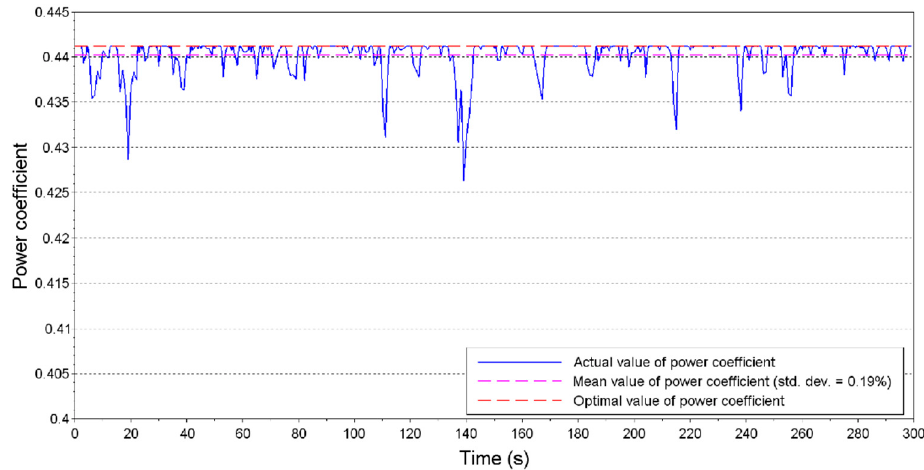
Figure 19. Comparison between the optimal value, the mean value and the actual value of the power coefficient.